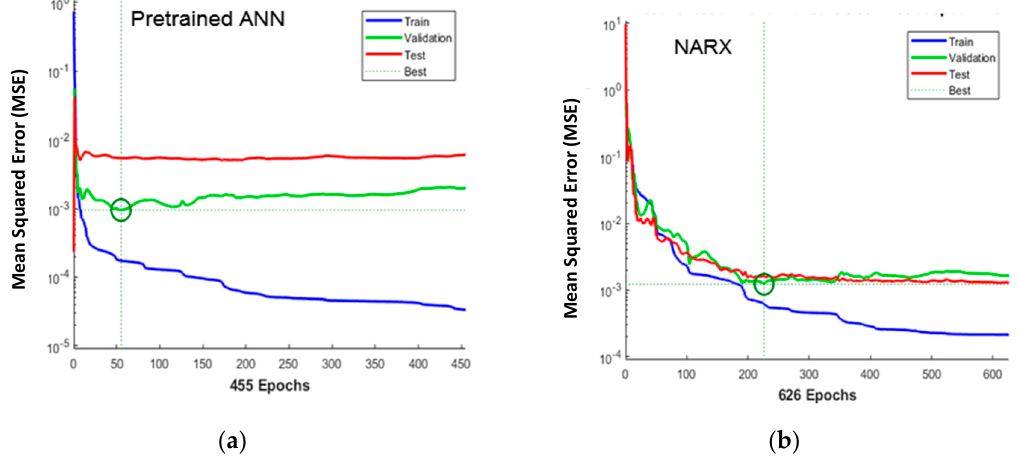
Figure 6. Training plots of ( a ) the pretrained ANN and ( b ) the NARX model for the industrial use case. The blue curves represent the MSE over the training epochs for the training data, the green curves represent the error for the validation error, and the red line represents the error for the test data. The green circle marks the optimal validation performance. The training curves of every